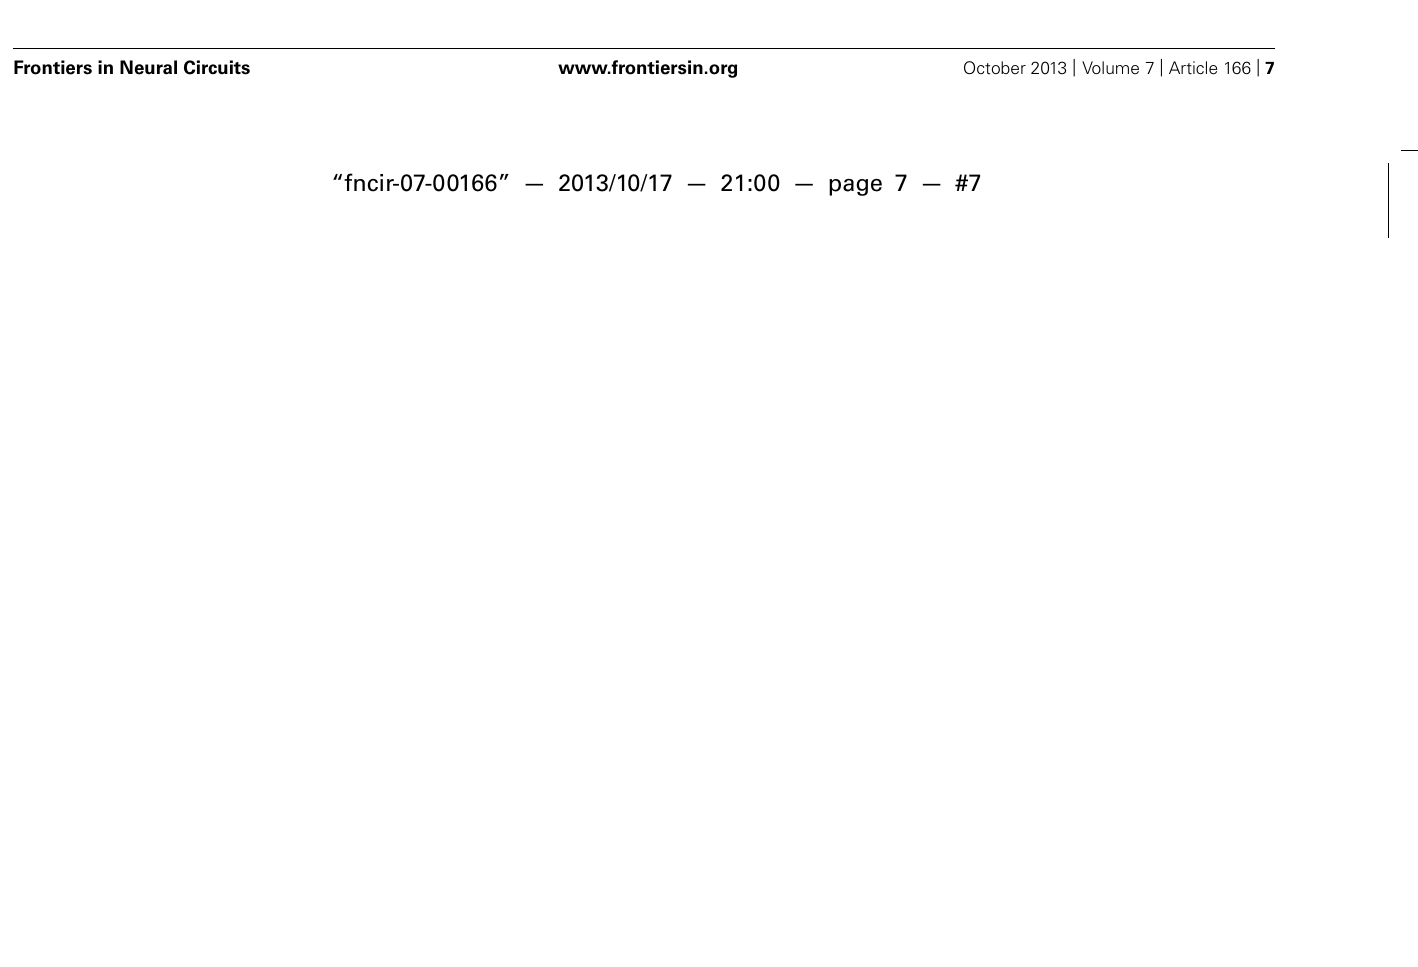
of each plot. (A) High correlation examples are shown for the three vocalizations presented in Figure 1 . (B) The lowest correlation examples across our data set are shown for the three